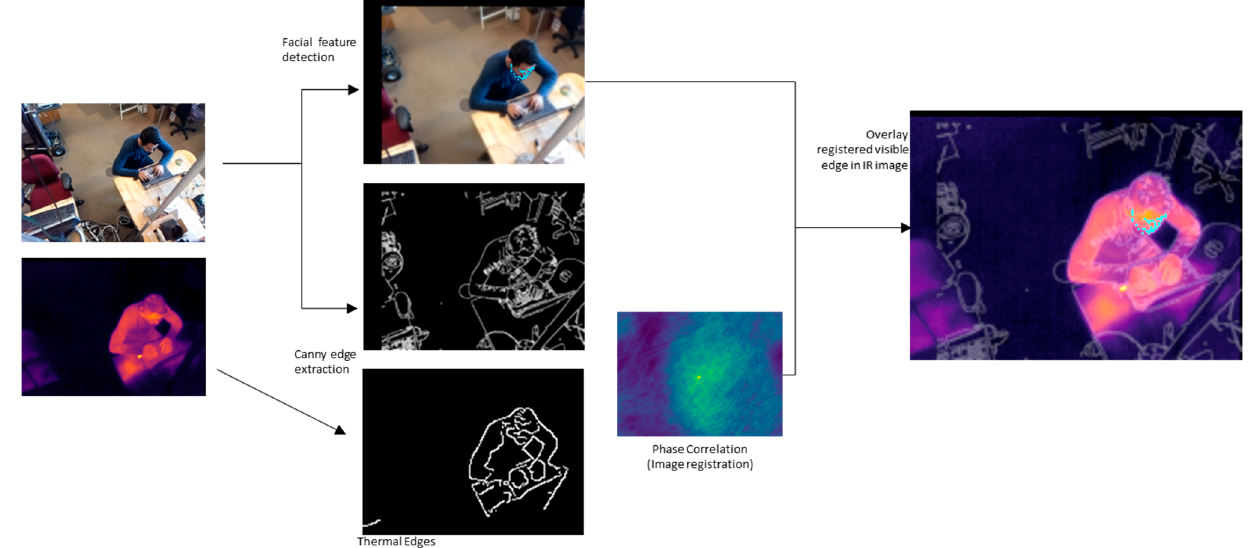
Figure 1. System architecture of the visible light and infrared image fusion.